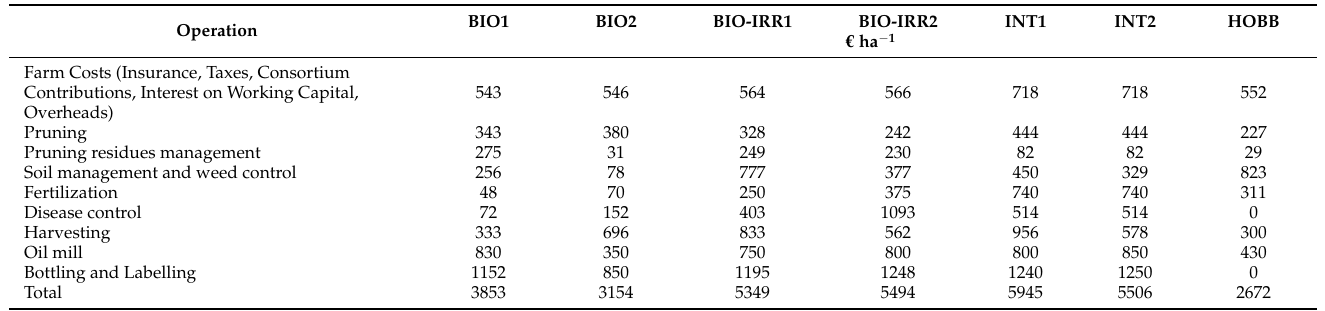
Table 9. Costs broken down by operation and by analyzed olive system. Values are in euro per hectare ( € ha − 1 ).